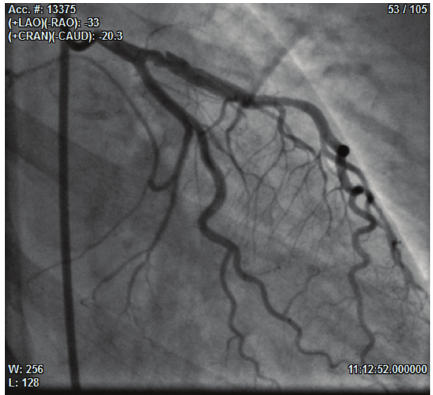
Figure 3: (33 ∘ RAO and 20 ∘ CAU): angiographic control at day 25 showing reopened LAD with TIMI 3 flow in the whole vessel.